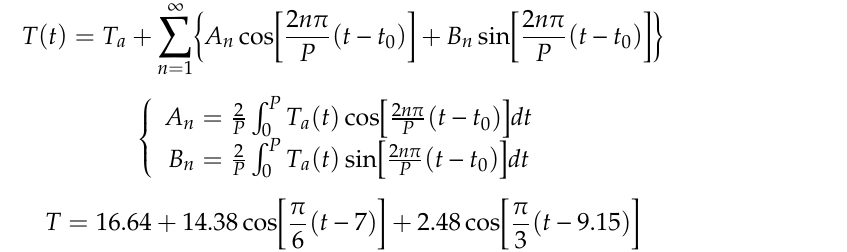
Figure 7. Schematic diagram of the arrangement of reinforced stress gauges in concrete piers.